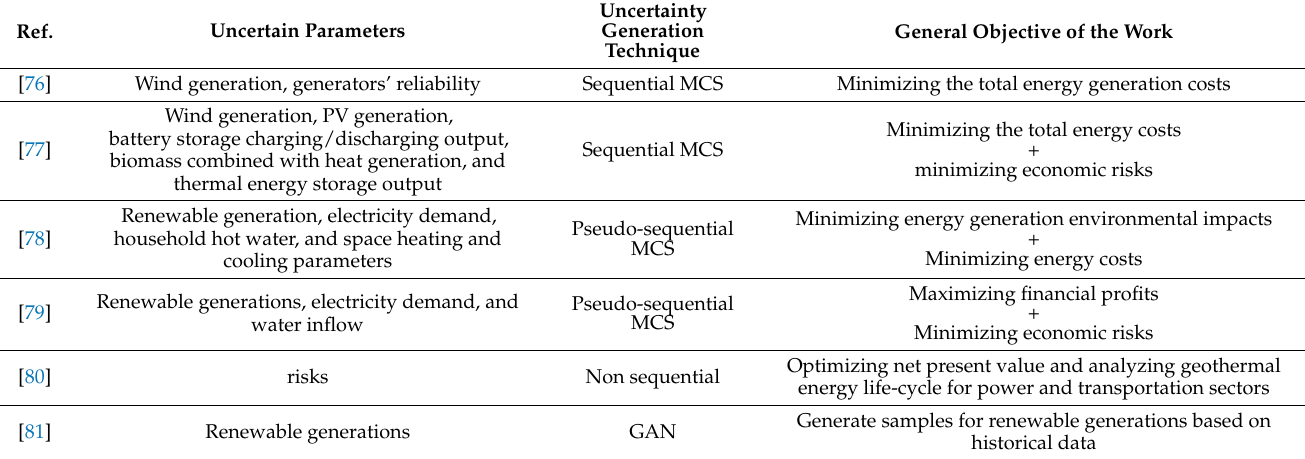
Figure 5. Uncertainty modelling techniques utilized in a smart grid environment. Table 5. An overview of selected papers using scenario generation techniques in a smart grid environment.